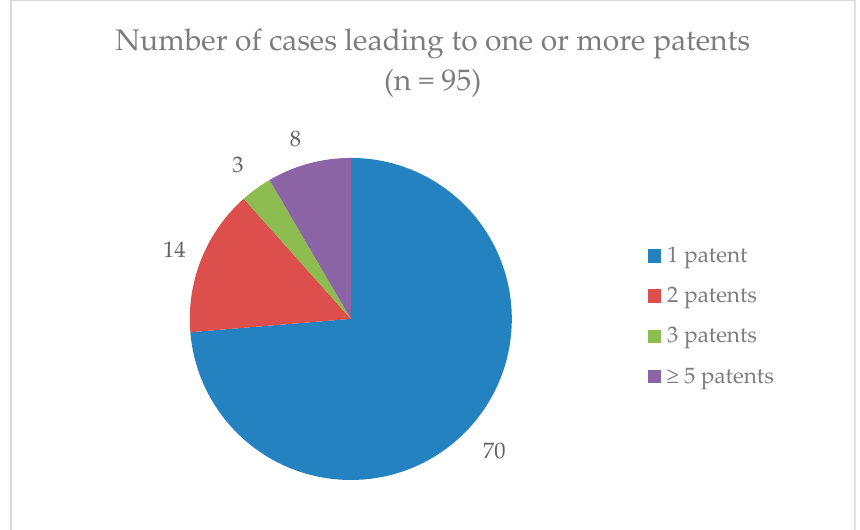
Figure 4. Number of patents per BID concept based on the BioM Innovation database [22]. As shown, 70 BID concepts led to a single patent (74%), 14 to two patents (15%), 3 to three patents (3%), and 8 to five or more patents (8%).